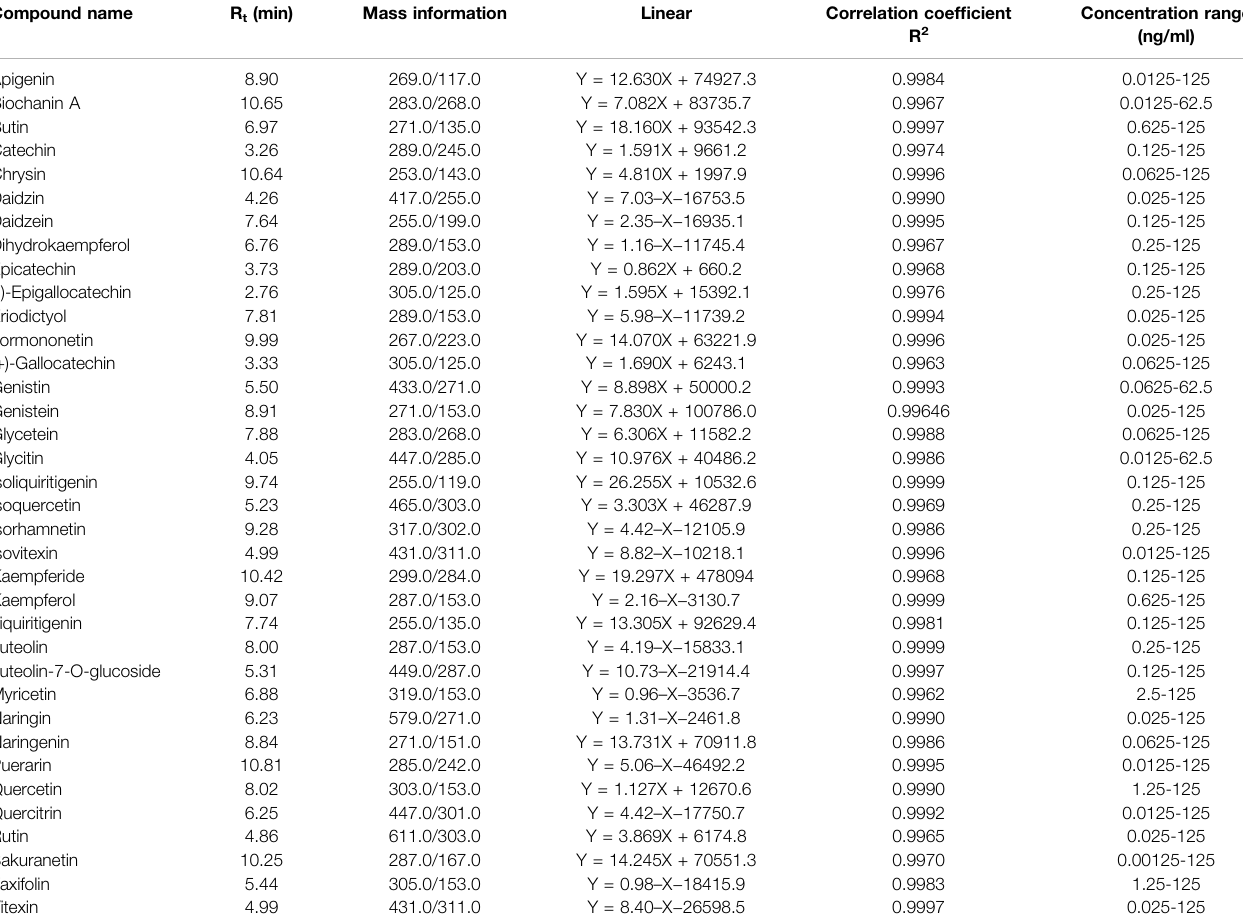
TABLE 3 | The retention times, mass information, standard curves, and concentration range of 36 fl avonoid